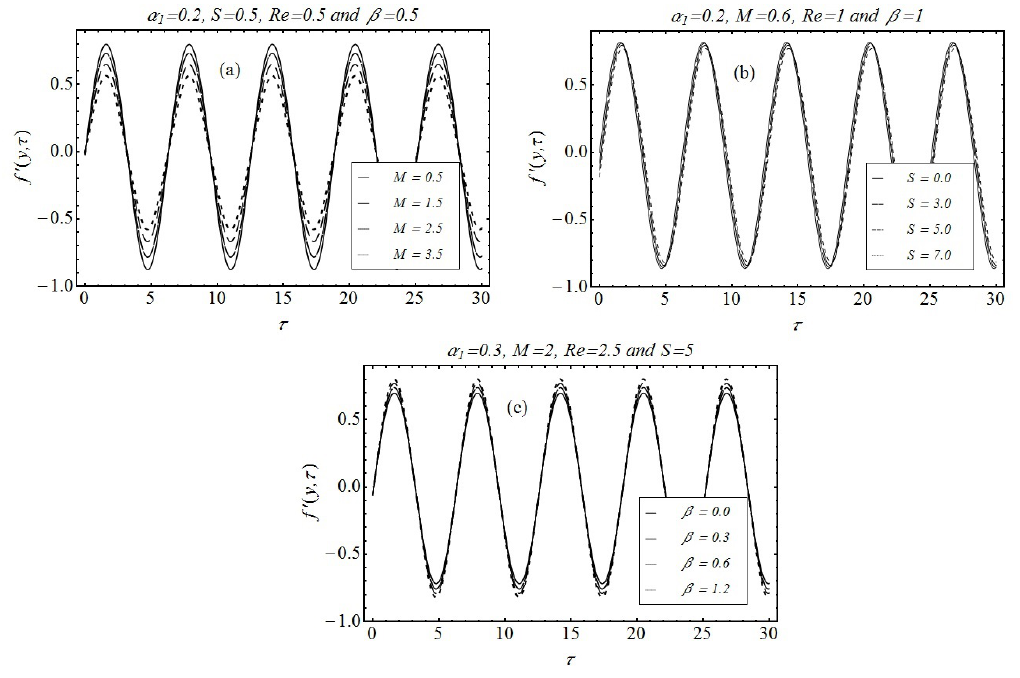
Figure 4: Time series of velocity profile (a) effects of M (b) effects of S (c) effects of β .